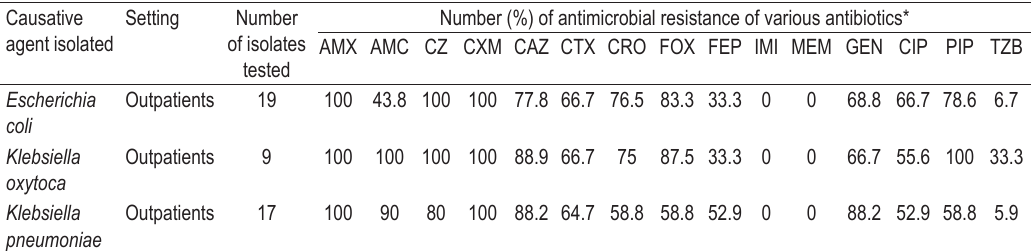
TABLE 1. Antimicrobial resistance of beta‑lactamase‑producing isolates collected from clinical outpatient samples Causative agent isolated